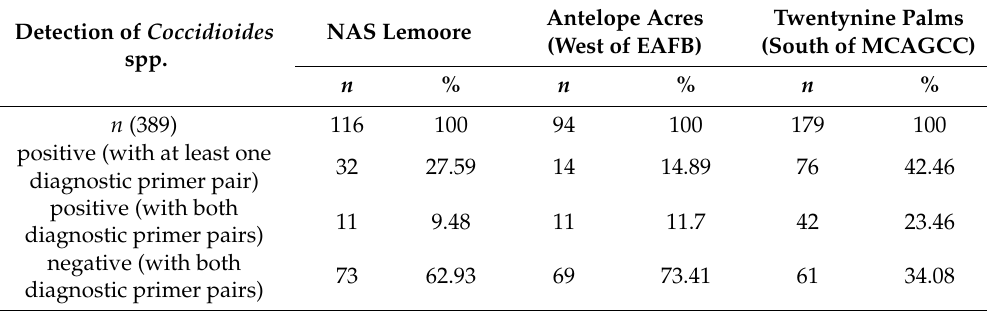
Table 5. Diagnostic PCR results for all soil DNA extracts ( n = 389) (ITSC1Af / r and EC3f / EC100r). Antelope Acres Twentynine Palms Detection of Coccidioides NAS Lemoore (West of EAFB) (South of spp.